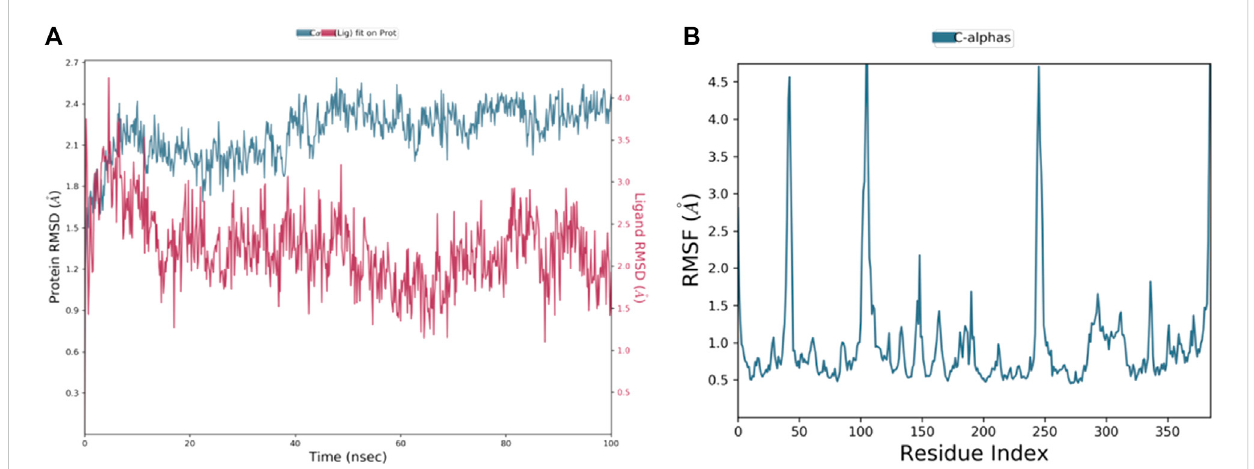
FIGURE 6 RMSD and RMSF plots for a ligand-protein complex during 100 ns of MD simulation. (A) Representation of ligand – protein complex. (B) Major fl uctuations at peak 1, 2, 3, and